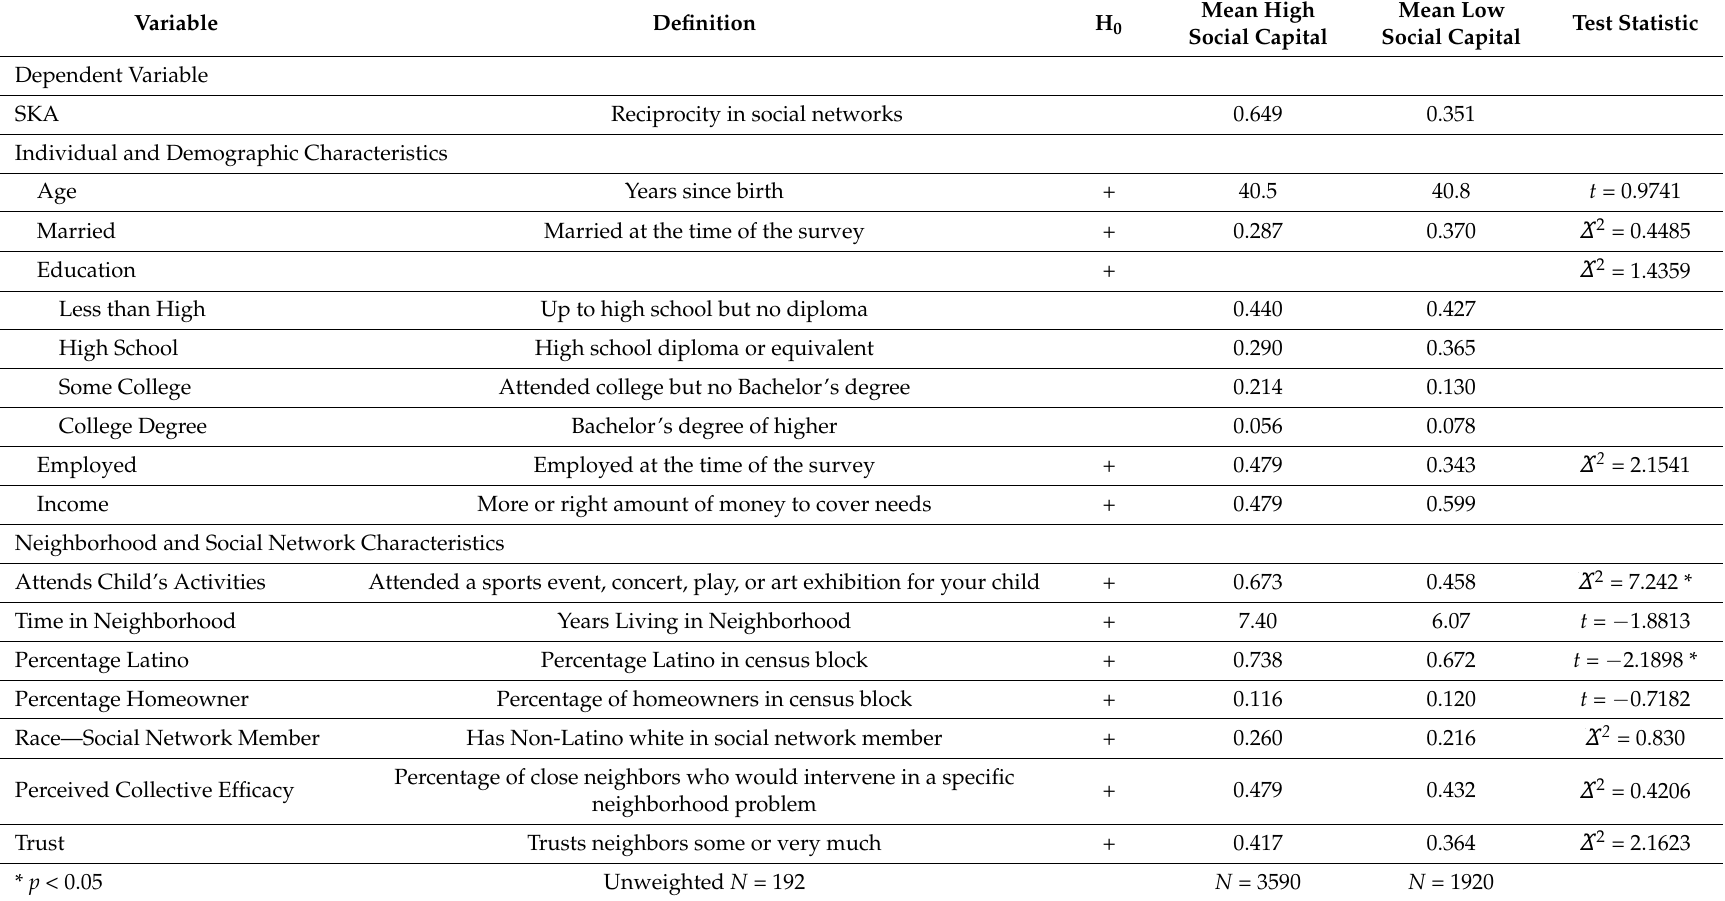
Table 2. Descriptive Statistics of Explanatory Variables Used in Logistic Regression of Puerto Rican Mothers’ Social Capital Accumulation.